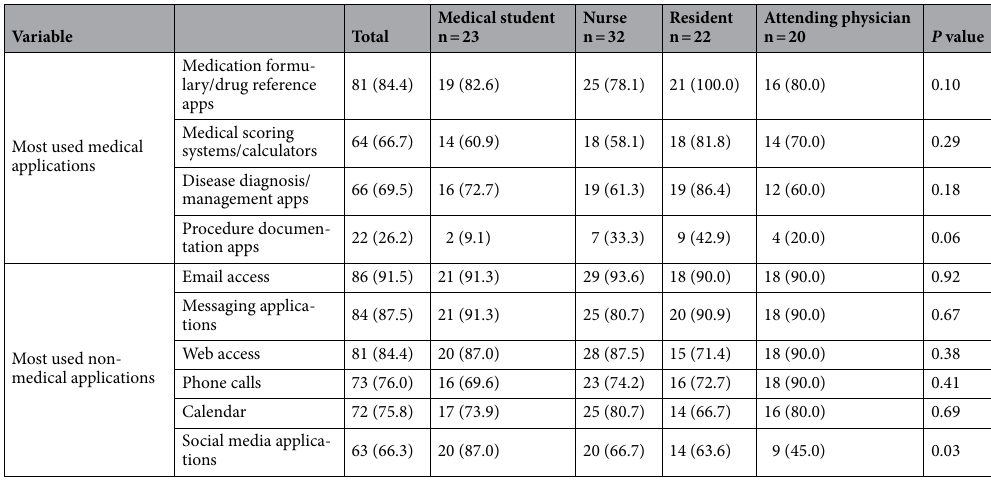
Table 3. Most used medical and non-medical applications stratified by HCP category a, b, c . a Cell counts may not add up to the raw total due to missing responses in the data. b Valid percentages were used. c Answers are not mutually exclusive, each respondent chose all that were applicable.